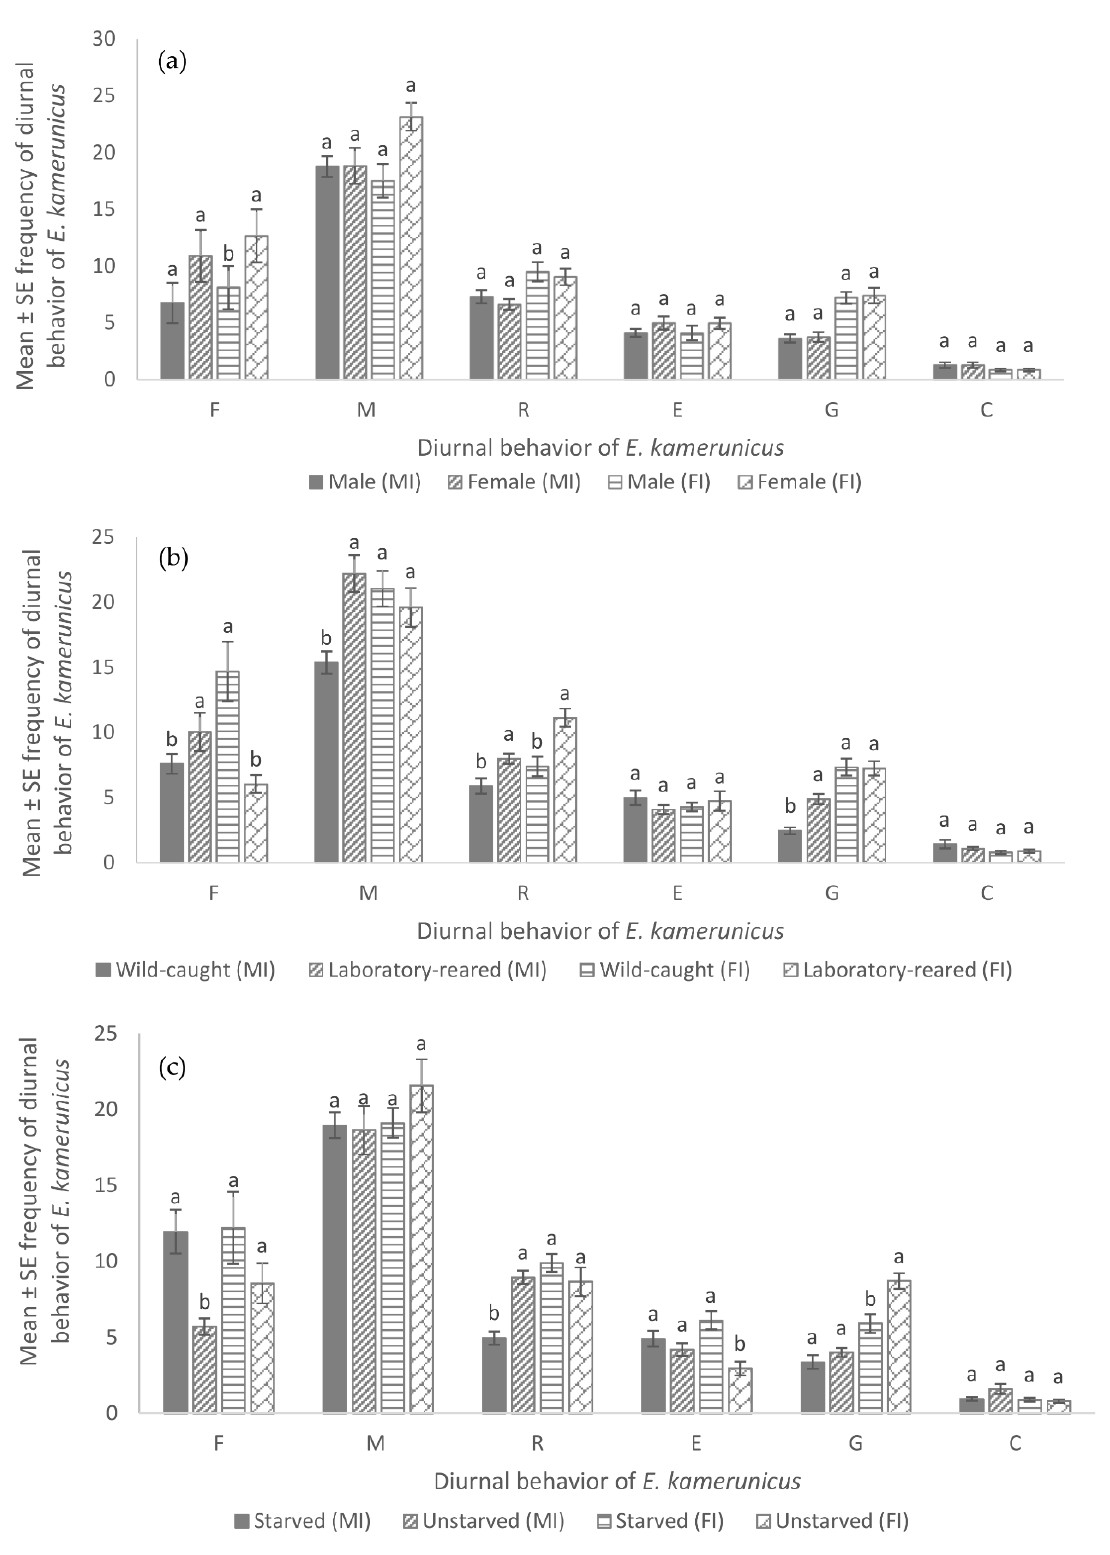
Figure 1. Mean (± SE) frequency of diurnal behavior of E. kamerunicus between ( a ) sexes ( b ) sources of E. kamerunicus and ( c ) levels of starvation on oil palm male inflorescence (MI) and female inflorescence (FI); F = flying, M = moving, R = resting, E = eating, G = grooming, C = mating/copulate. Note: same case letters indicate that there is no significant difference ( p < 0.05).